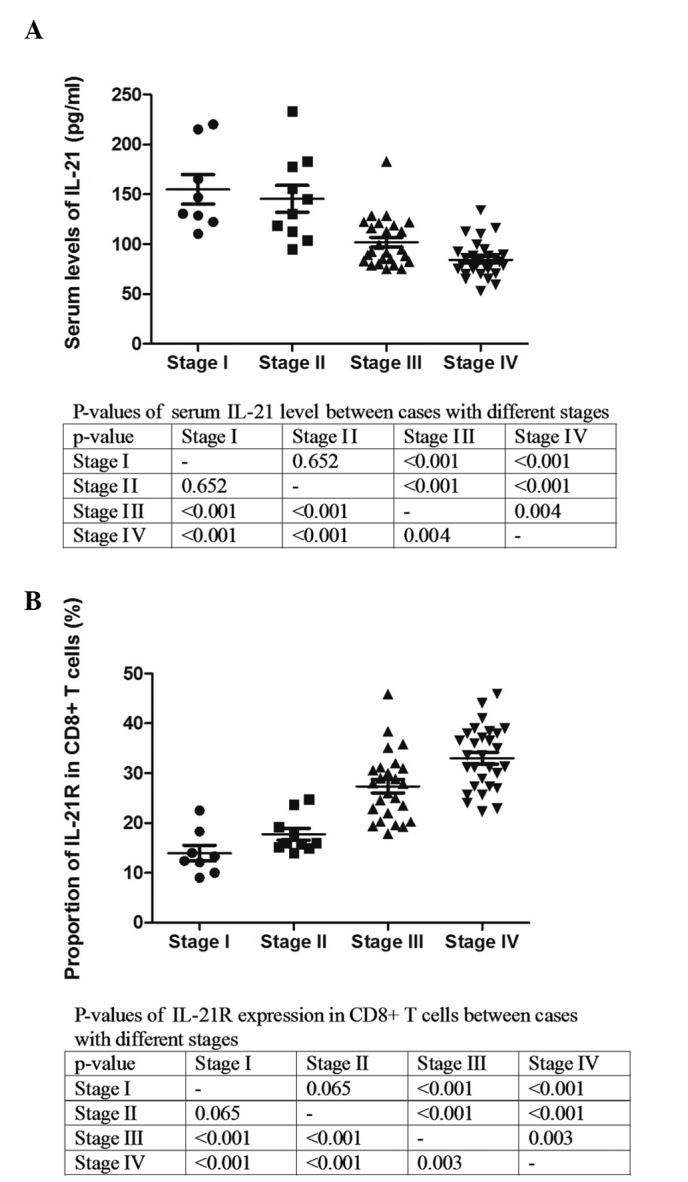
(A) Serum levels of IL-21 and (B) IL-21R expression on peripheral CD8+ T cells in the patients with DLBCL with different Ann Arbor stages. Each symbol represents a subject. P-values of each comparison are shown in the tables below. IL-21, interleukin 21; IL-21R, IL-21 receptor; CD8, cluster of differentiation 8; DLBCL, diffuse large B-cell lymphoma.